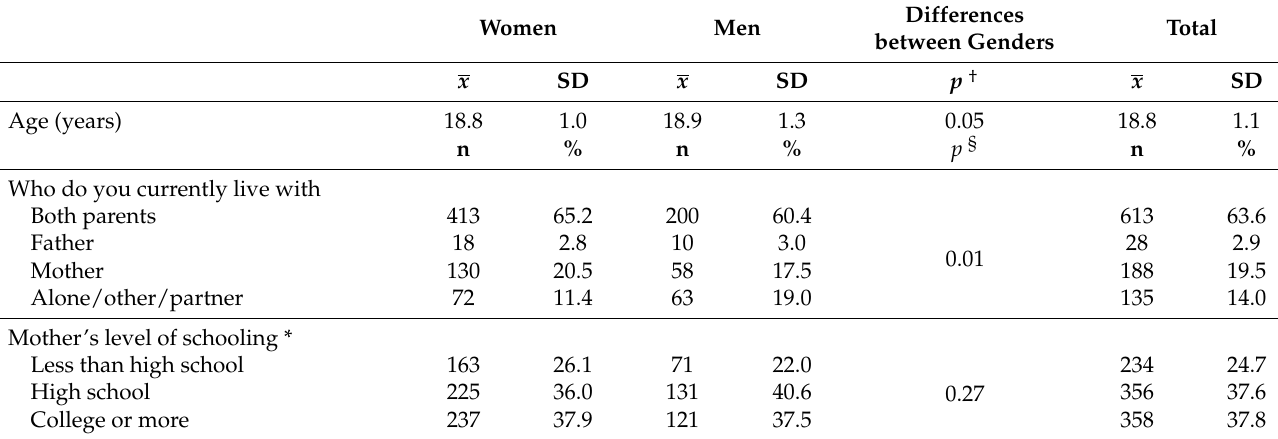
Table 1. Characteristics of study participants (n =